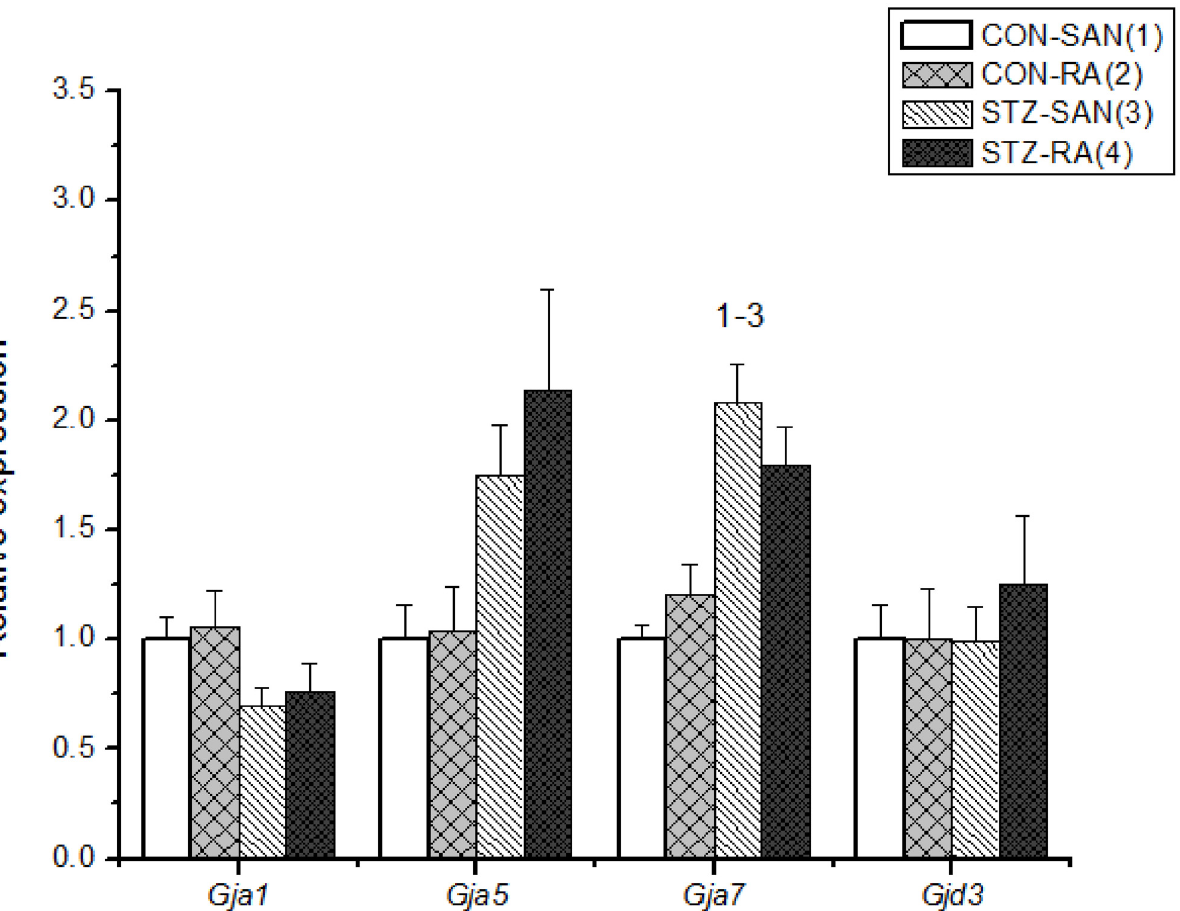
Fig 4. Expression of genes encoding various intercellular proteins. Data are mean ± SEM, n = 6 – 10 samples from STZ and control rat each containing SANs from 2 hearts.